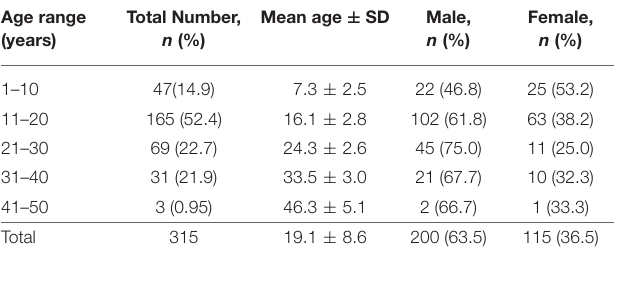
TABLE 1 | Age and gender wise distribution of epilepsy in 315 epileptic patients.